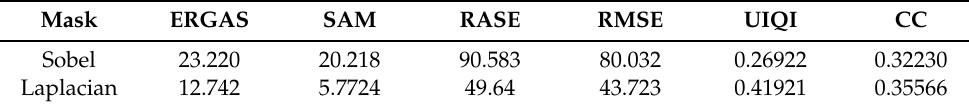
Table 6. Results for integer order